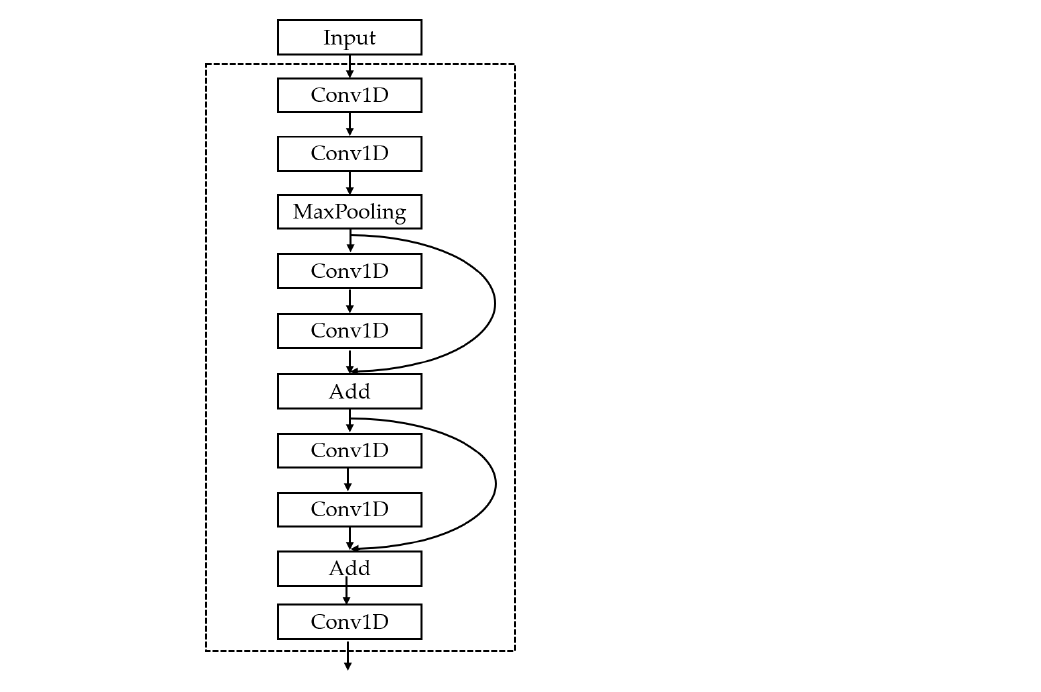
Figure 5. The 1D-CNN model structure.